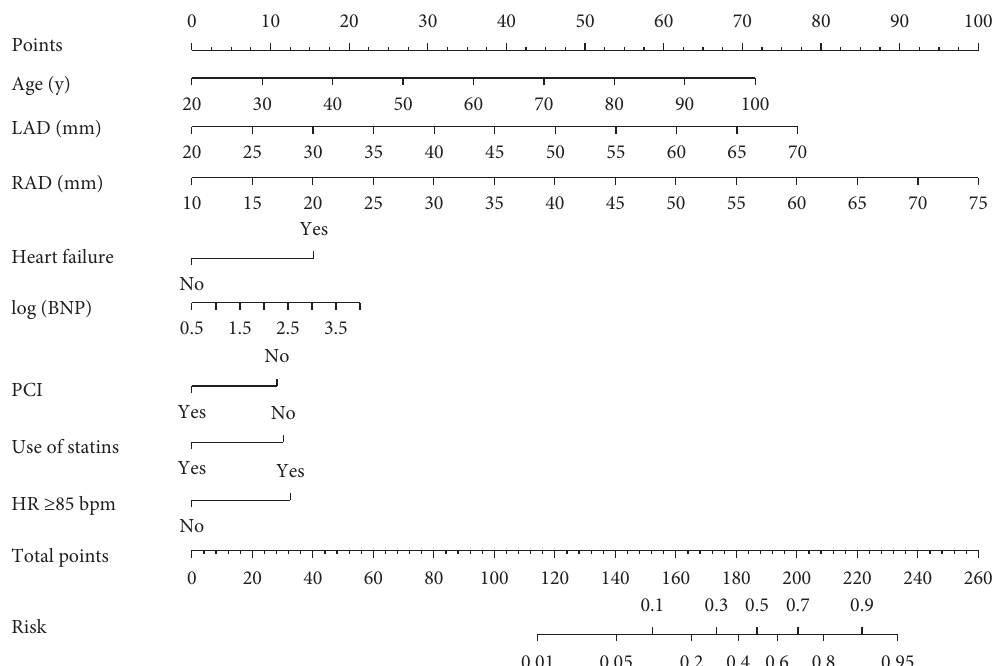
Figure 4: Nomogram to predict NOAF risk during hospitalization in ACS patients. To use the nomogram, an individual patient’s value was located on each variable axis, and a line was drawn upward to determine the number of points received for each variable value. Te sum of these numbers was located on the total points axis, and a line was drawn downward to the risk axis to determine the risk of NOAF presence. LAD, left atrial diameter; RAD, right atrial diameter; BNP, brain natriuretic peptide; PCI, percutaneous coronary intervention; HR, heart